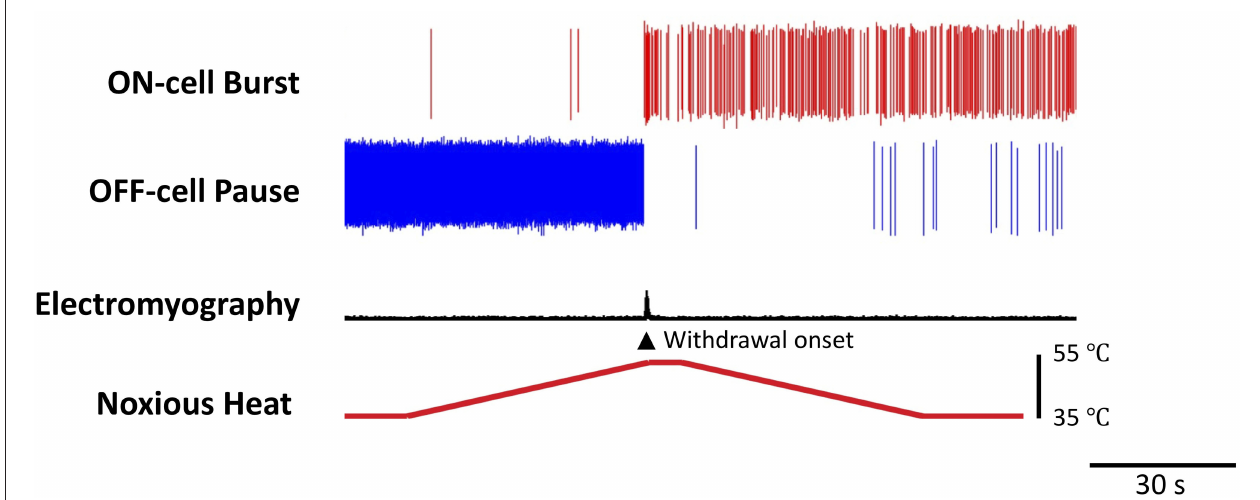
FIGURE 2 | Reciprocal firing patterns of pain-modulating RVM ON- and OFF-cells. Examples of ON- and OFF-cell firing changes associated with nocifensive withdrawal evoked by a noxious heat stimulus. The OFF-cell pauses and ON-cell bursts immediately prior to the behavior. The threshold at which the OFF-cells pause correlates with the threshold for nocifensor withdrawals and periods of OFF-cell inactivity are associated with a lower threshold (16). In contrast, the magnitude of the ON-cell burst is positively correlated with the magnitude of behavioral responses ( 17). Heat (bottom trace) was applied to the plantar surface of the hind paw using a Peltier device. Withdrawal reflex was monitored using an electromyogram (EMG). The OFF-cell “pauses” and ON-cell “bursts” immediately prior to the withdrawal. The duration of the pause and burst can range from a few seconds, as here, to many